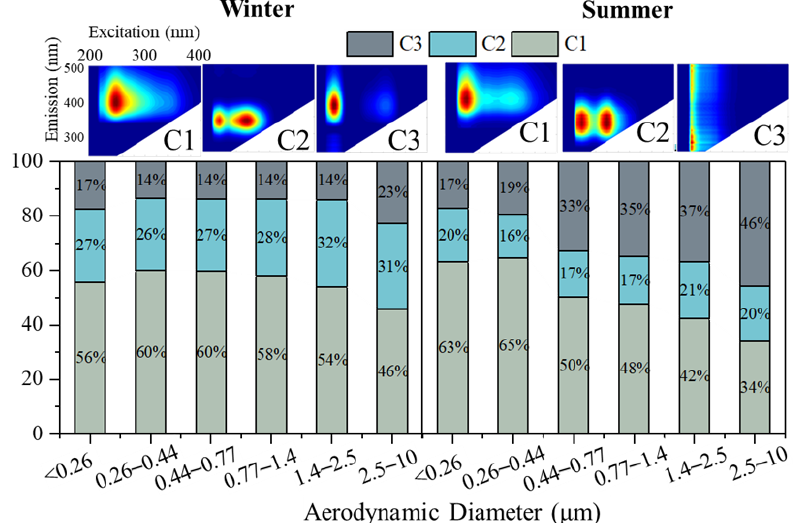
Figure 6. PARAFAC results of EEM in winter and summer, respectively. Three components were extracted for both seasons, and the proportions of each component for different particle sizes are also shown.